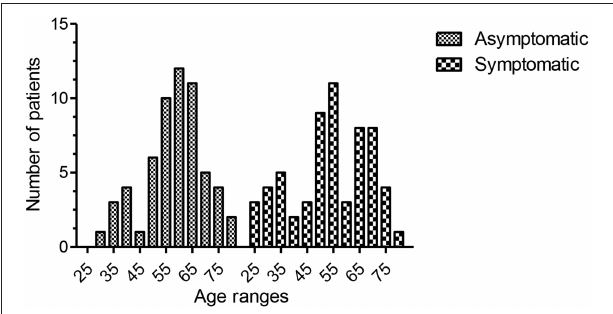
FIGURE 2 | Age ranges of the two groups. The mean age for the entire asymptomatic group was 58.16 (95th CI of mean = 55.18–61.16, range